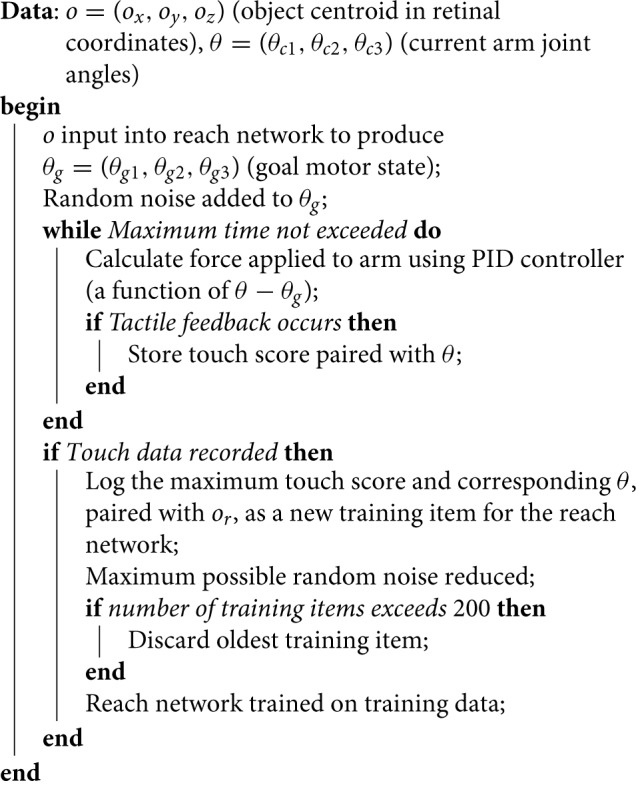
Learning Goal Arm states for reach actions